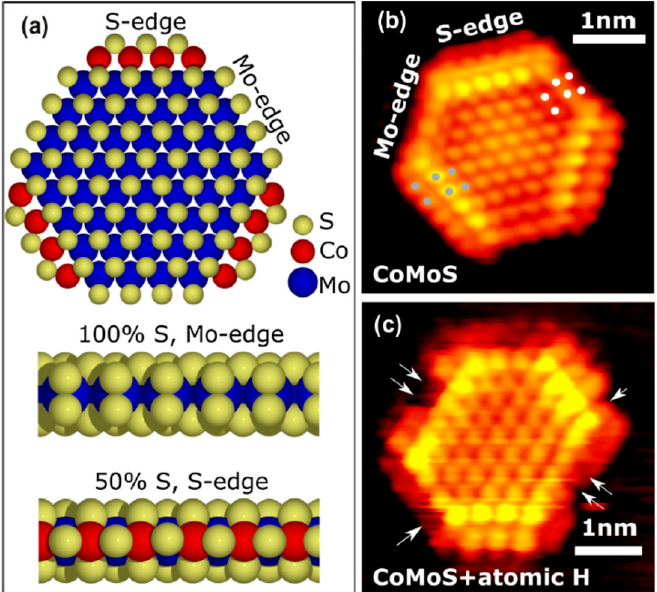
Figure 8. ( a ) Mo and S edges in CoMoS catalysts, ( b ) scanning tunneling microscopy (STM) images of the CoMoS nanocluster, ( c ) Formation of vacancies at the middle of Mo edge rather than the corner, on exposure of the hydrogen. Gronborg et al.